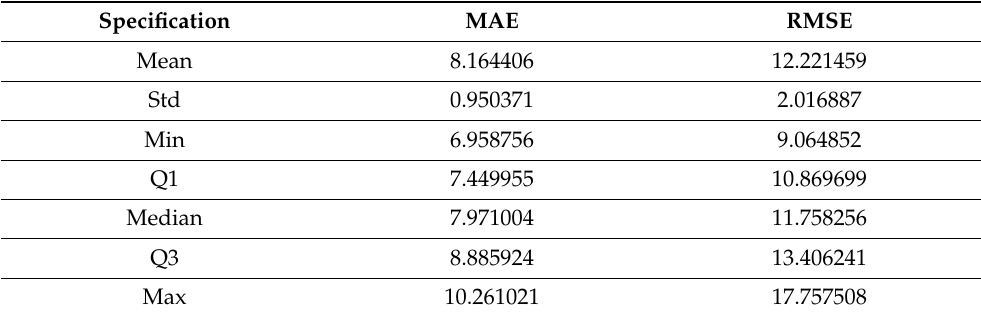
Table A1. Parameters of the model explaining pro-environment activities of agricultural